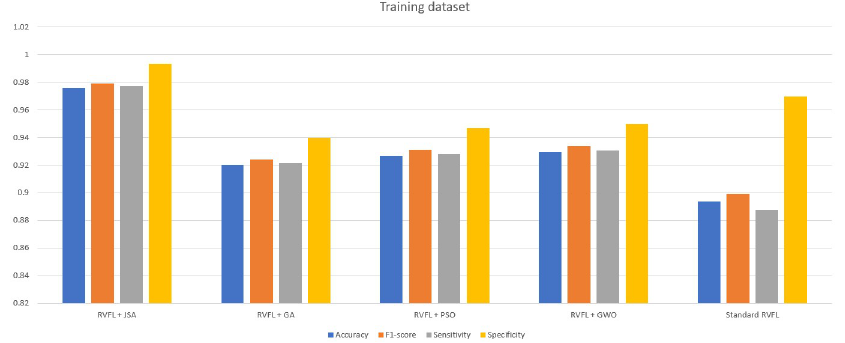
Fig 5. Accuracy, macro F1-score, sensitivity, and specificity for the training